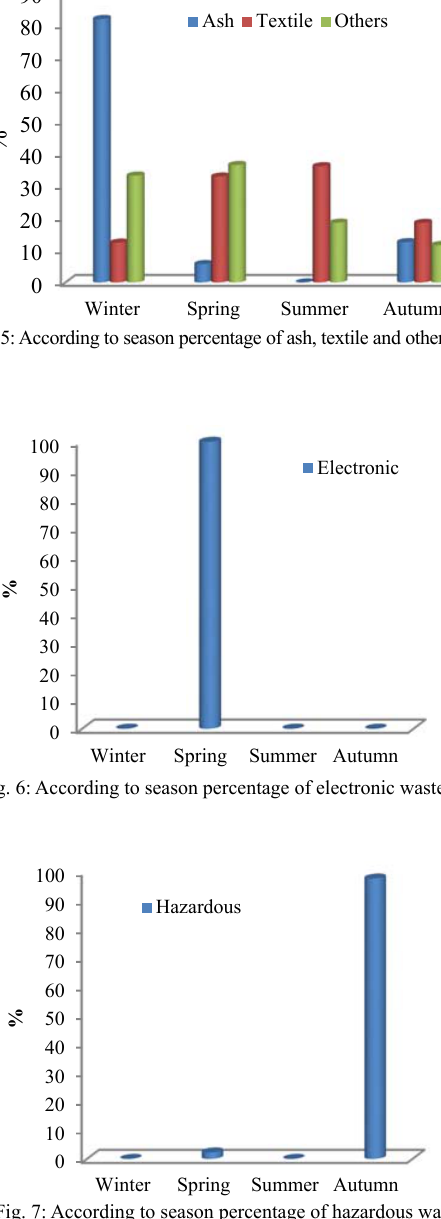
Fig. 7: According to season percentage of hazardous wastes